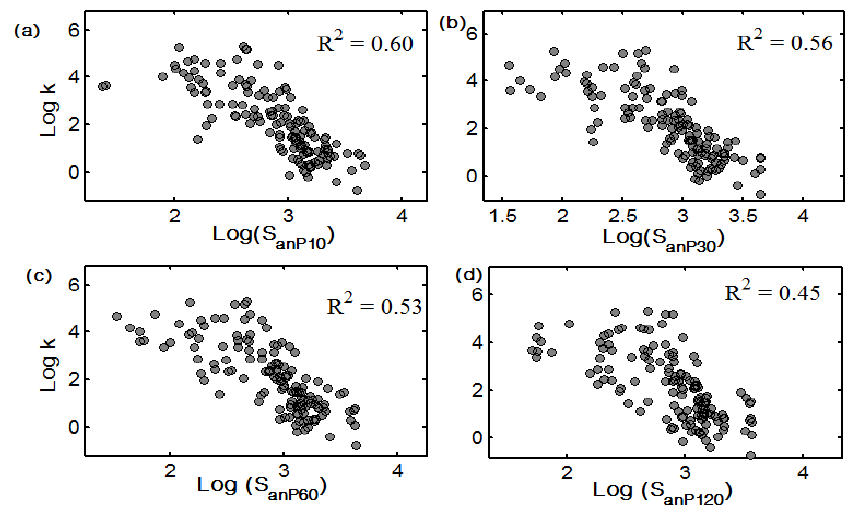
Figure 4. k vs. S anPN (past S an information) plots for basin 08153500 for four values of N: 10 ( a ), 30 ( b ), 60 ( c ), and 120 ( d ). Decrease of R 2 with N supports the hypothesis that the effect of catchment storage S an on discharge decreases with time.